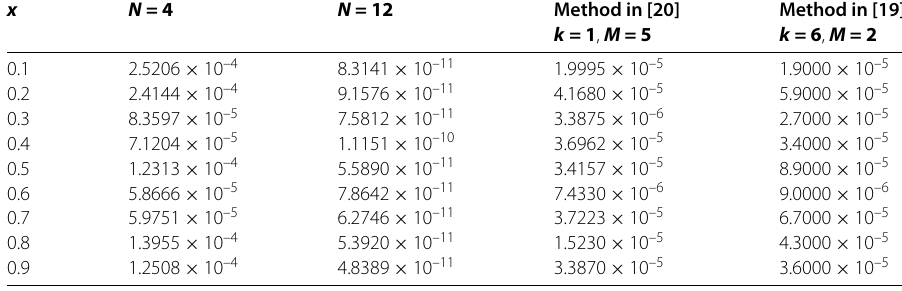
Figure 1 Comparison of y ( x ) for N = 8 and with α = 1/4,2/4,3/4,1 for Example